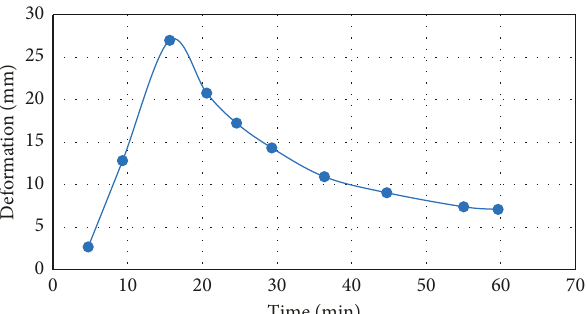
Figure 25: Changes in deformation in the asphalt phase under a mechanical loading of 25nN. The figure is reproduced from Dourado et